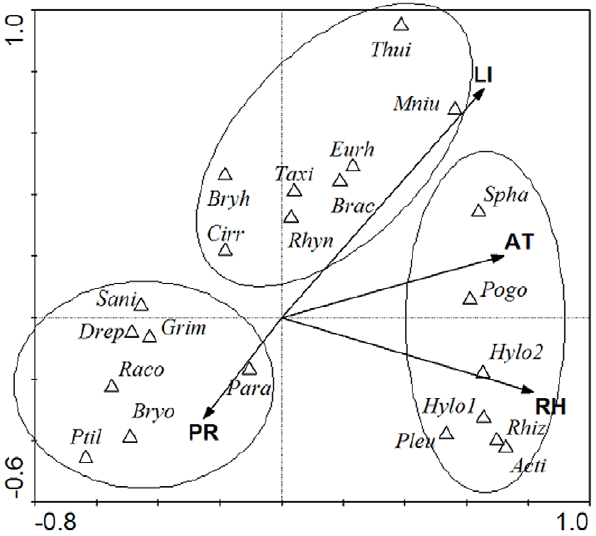
Figure 4. CCA ordination Bio-plot for the most abundance bryophyte species. Genus abbreviation: Acti=Actinothuidium, Brac=Brachythecium, Bryh=Bryhnia, Bryo=Bryonoguchia, Cirr=Cirri- phyllum, Drep=Drepanocladus, Eurh=Eurhynchium, Grim=Grimmia, Hylo1= Hylocomiastrum, Hylo2= Hylocomium, Mniu=Mnium, Para=- Paraleucobryum, Pleu=Pleurozium, Pogo=Pogonatum, Ptil=Ptilium, Raco=Racomitrium, Rhiz=Rhizomnium, Rhyn=Rhynchostegium, Sa- ni=Sanionia, Spha=Sphagnum, Taxi=Taxiphyllum, Thui=Thuidium ; Environment abbreviation: AT=Air temperature, LI=Depth of litter, PR=Precipitation, RH=Relative humidity.